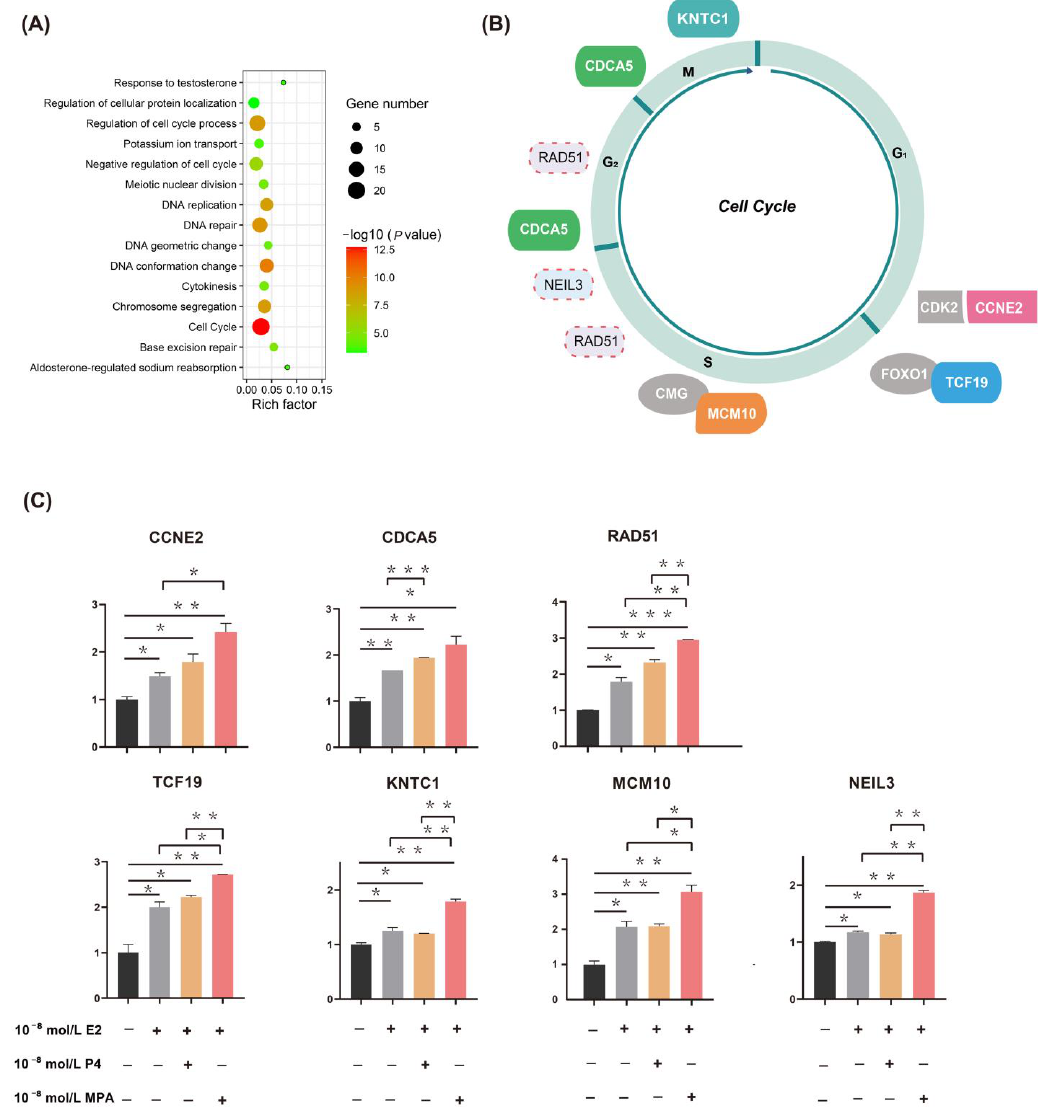
Figure 3. Seven upregulated candidate genes are related to cell cycle and genome stability. ( A ) Top 15 enriched biological functions of intersected differentially expressed genes (DEGs) in which P4 group and MPA group intersect with BRCA group. The color of each point represents the value of -log10 ( p -value), and the size of each point corresponds to the number of DEGs represented in the functional term. The rich factor is the percentage of all the DEGs found in the given ontology term. Altogether, most of the 96 upregulated DEGs are associated with cell cycle and genome stability. ( B ) A simple model of cell cycle regulation. The cell cycle is divided into four main stages: the gap 1 phase (G1), synthesis phase (S), gap 2 phase (G2), and mitotic phase (M). Seven genes ( CCNE2, CDCA5, RAD51, TCF19, KNTC1, MCM10, and NEIL3 ) regulated by EPT are indicated with colored boxes and placed near the corresponding cell cycle phases. The gray boxes indicate the proteins they bind. The solid line box represents the effect of genes on the cell cycle has been well documented, and the dotted line box represents the effect of genes on the cell cycle documented in the few studies. ( C ) RT-qPCR validation of candidate genes expression ( CCNE2, CDCA5, RAD51, TCF19, KNTC1, MCM10, and NEIL3 ) in human breast cancer cells. The mRNA expression of all seven genes increased evidently in EPT compared to the ET ( p < 0.05). * p < 0.05, ** p < 0.01, and *** p < 0.001. E2, 17 β -estradiol; P4, progesterone; MPA, medroxyprogesterone acetate. EPT, estrogen plus progestogens treatment; ET, estrogen